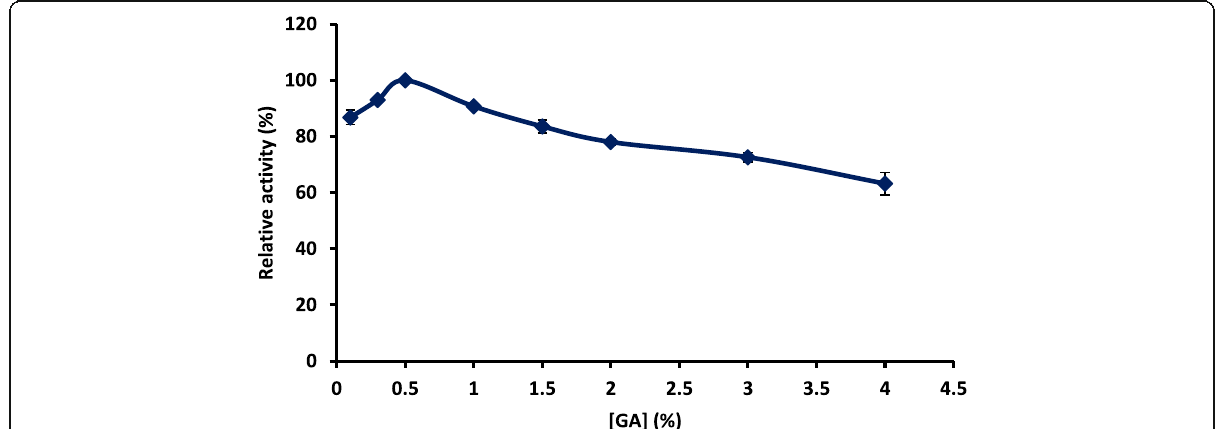
Fig. 5 Effect of variation of GA concentration on the catalytic activity of immobilized